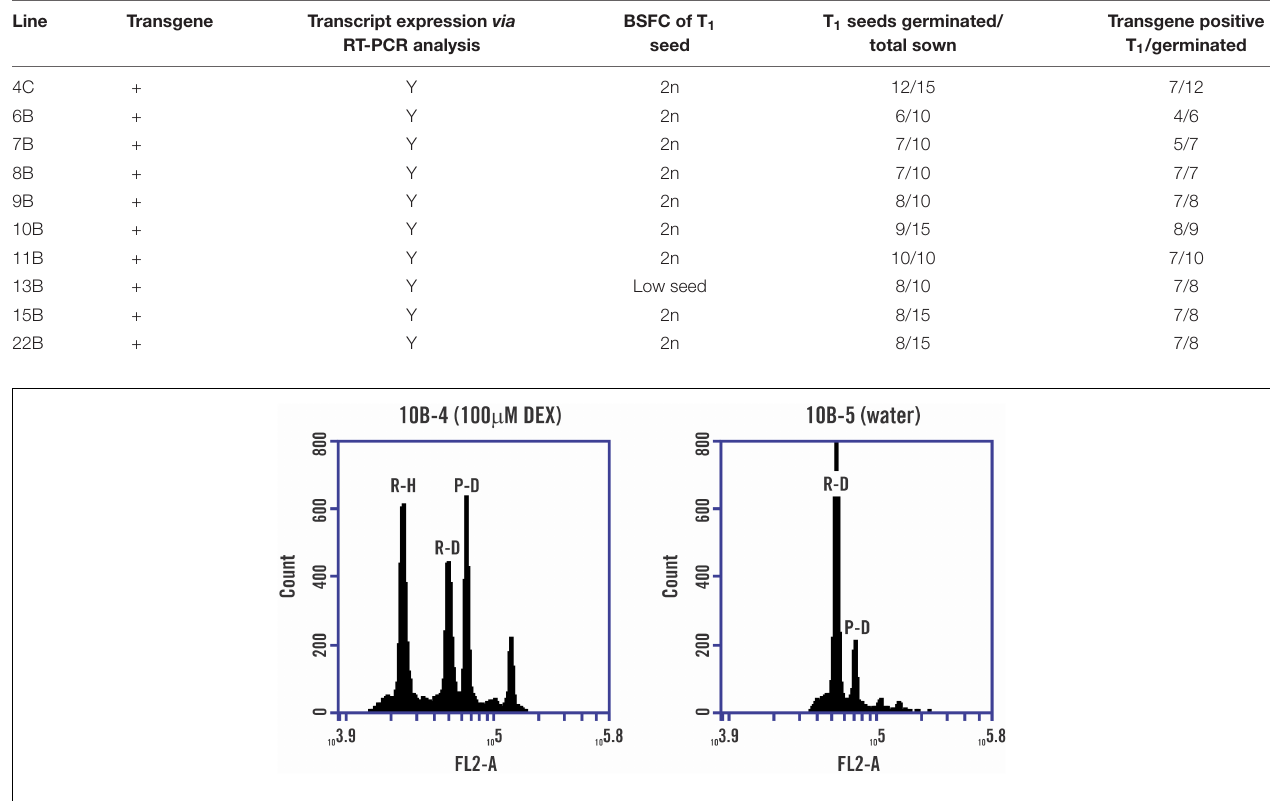
FIGURE 2 | Representative BSFC to identify parthenogenesis. Embryos from five seeds were bulked, processed, and analyzed with flow cytometry to determine if PsASGR-BBML:GR would induce haploid embryo development when induced with DEX. Line 10B-5, transgene positive, without DEX treatment did not display a haploid signal. 10B-4, transgene positive, with 100 µ M DEX treatment displayed both haploid and diploid rice signals from bulked embryo tissue. R-H (rice haploid signal), R-D (rice diploid signal), and P-D ( Paspalum notatum diploid signal). The plots shown are based on a linear Y-axis count number and a logarithmic X-axis FL2-A